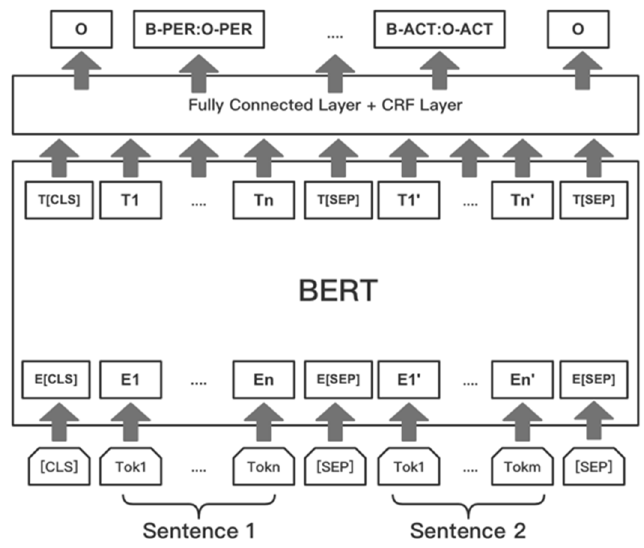
Figure 2. NER based on